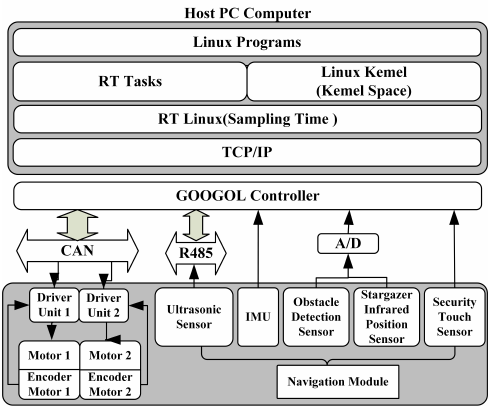
Figure 6. Implementation architecture of WMR.